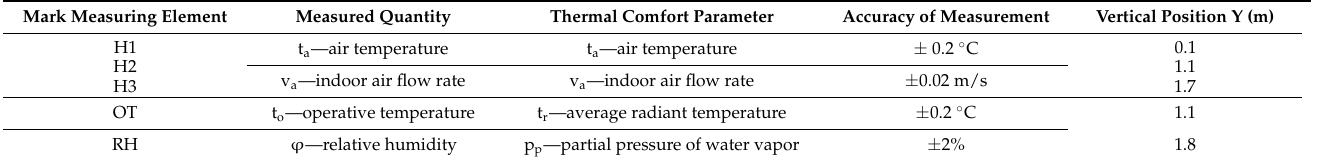
Table 2. Marking of measuring members, measured quantities and measurement accuracy for the ComfortSense